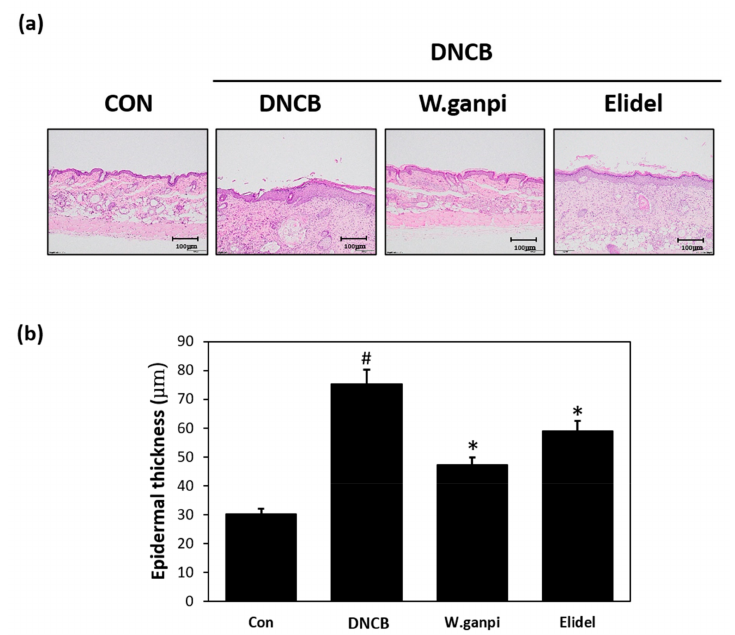
Figure 2. Effects of WGE on the change of the epidermal thickness in AD-like symptoms induced by DNCB in hairless mice. ( a ) Results of changes in epidermal thickness of skin lesions confirmed by histopathological examination. Stained by Hematoxylin and eosin (H&E) staining; ( b ) Epidermal thickness. CON: control group, DNCB: DNCB-treated group, W. ganpi : DNCB and 1% W. ganpi EtOH extract-treated group, Elidel: DNCB and Elidel cream treated group. # p < 0.05 vs. the CON group; * p < 0.05 vs. the DNCB group.